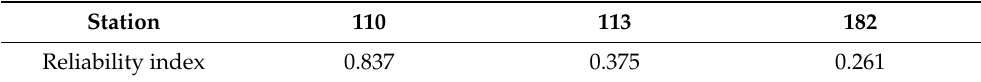
Table 3. Reliability index for each station.